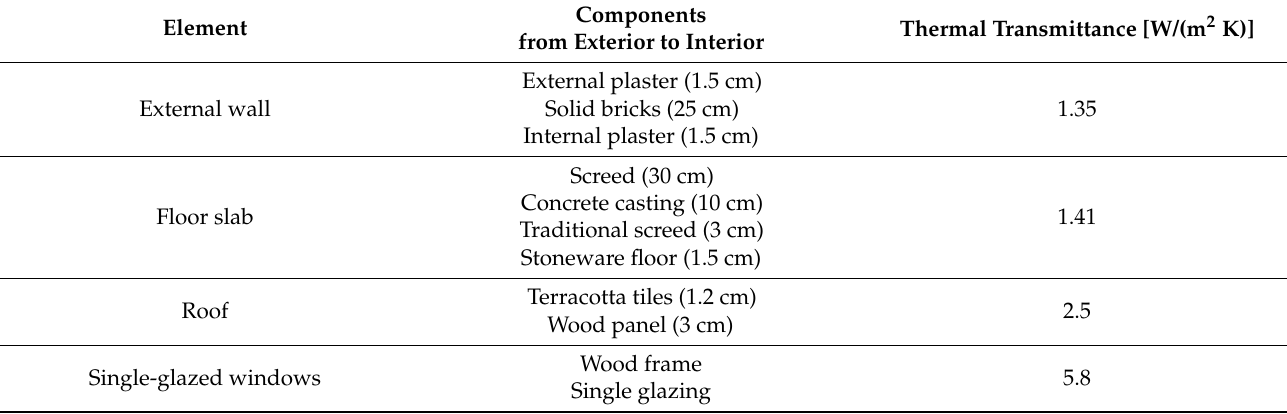
Table 1. Thermal transmittance and components of the envelope